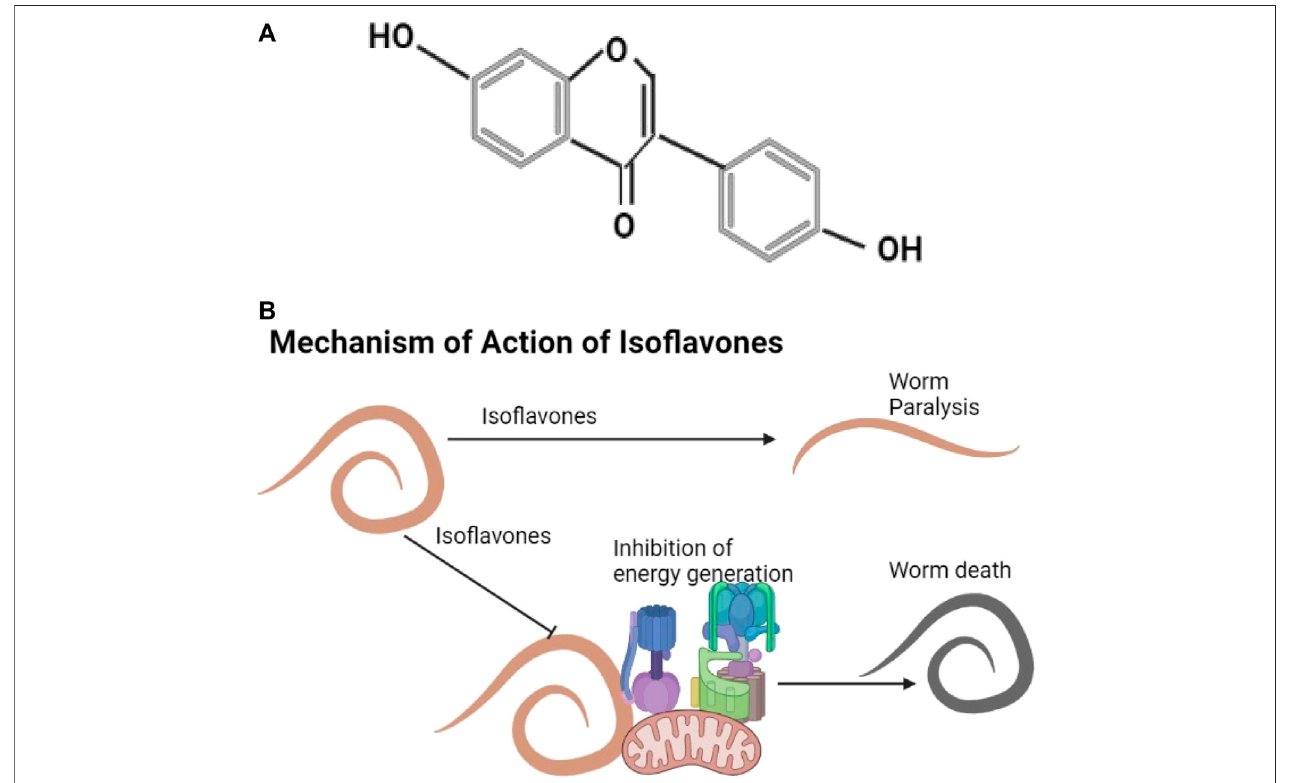
FIGURE 6 | (A) The structure of daidzein (Hampl et al., 2009). (B) Iso fl avones cause helminth paralysis and inhibit energy